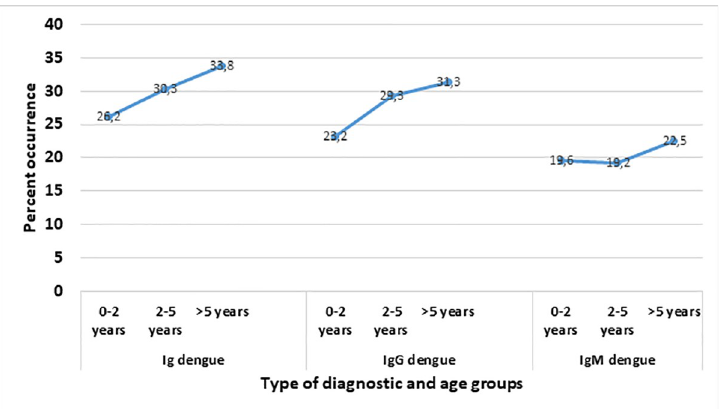
Fig 2. Diagram showing the variation of the prevalence of dengue in relation to age group. Ig represents all cases of dengue infections (past and current infections). IgG represents cases of previous exposure to dengue. IgM represents current cases of dengue.